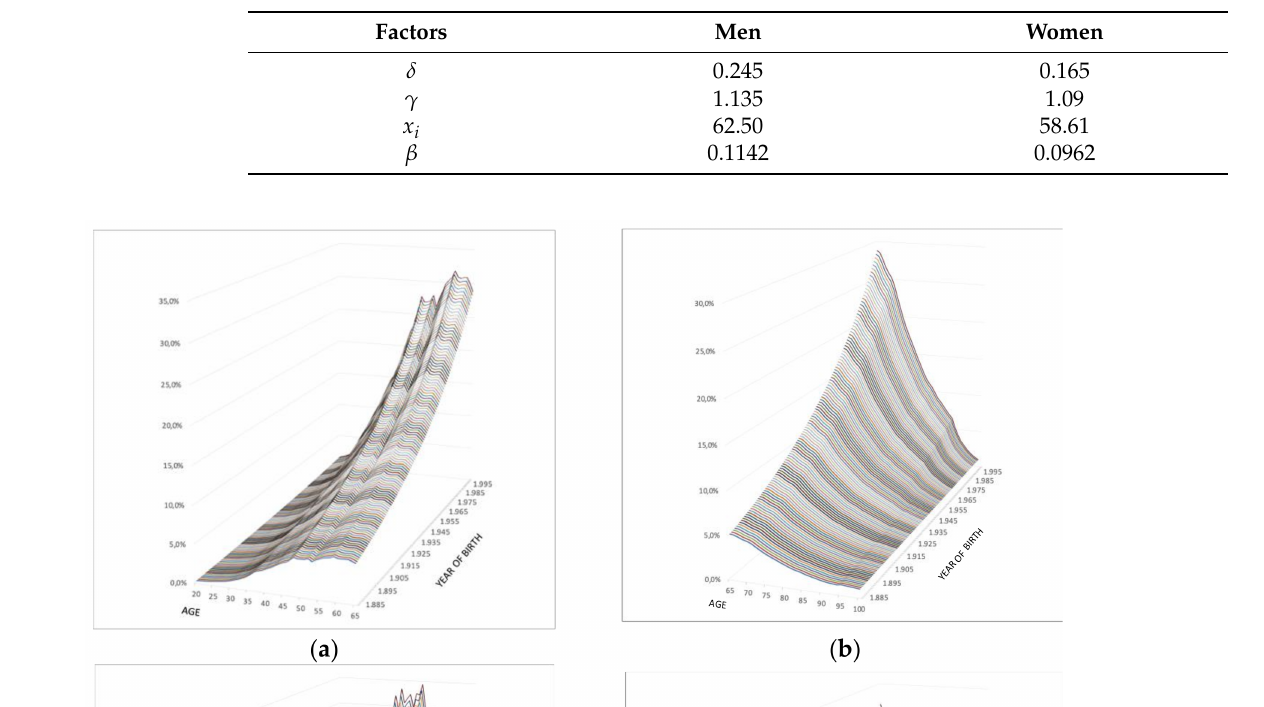
Table 2. Dependent excess mortality factors for the degree of severe and high dependency in Spain. Source: [84].